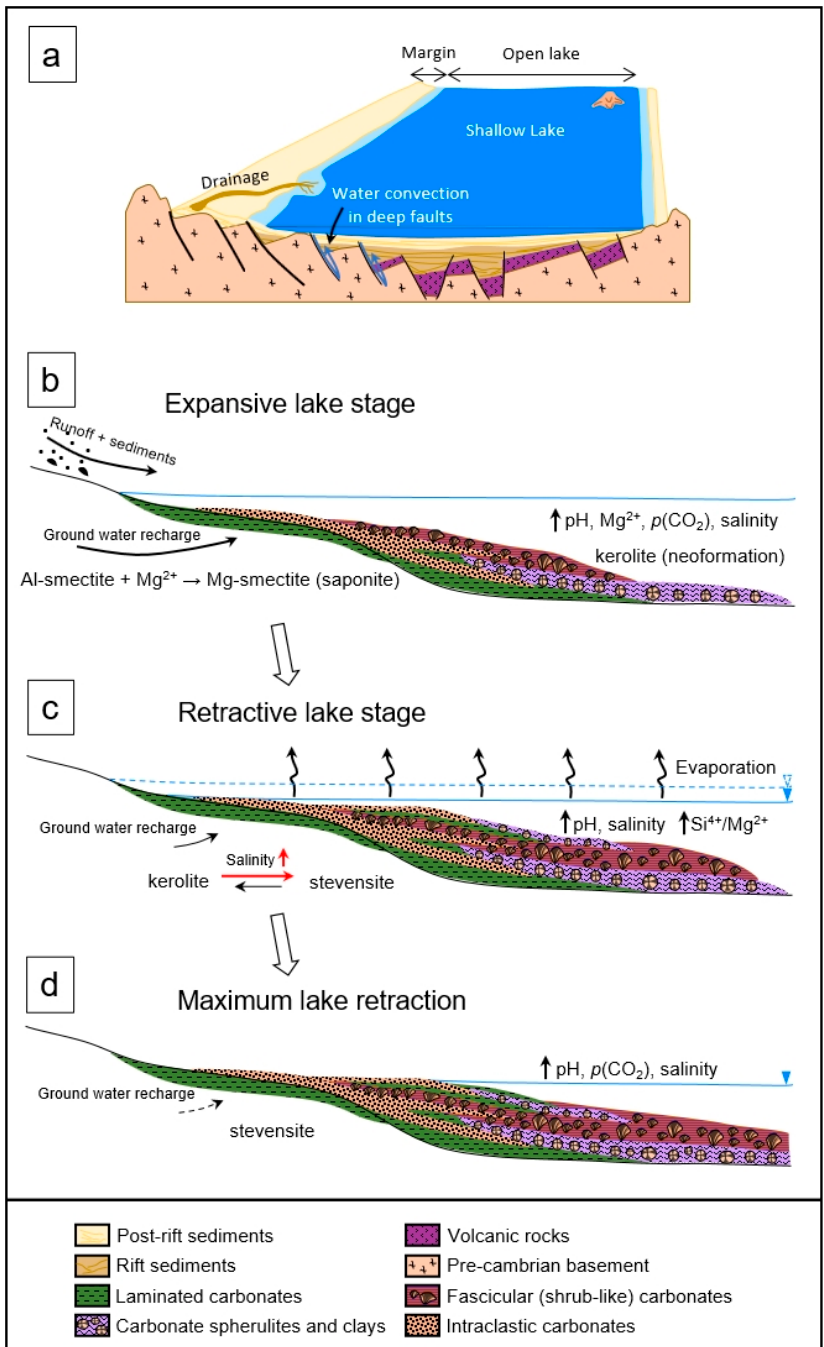
Figure 9. Scheme showing the conceptual depositional model for the post-rift stage, including main Mg-clay minerals authigenic pathways. ( a ) shows a simplified conceptual model illustrating the geology and hydrology of the Barra Velha Fm as a large and shallow endorheic lake (modified from Pietzsch [21]). ( b ) illustrate the expansive lake stage with runoff water and sediment discharge plus ground water contributing to lake water dilution favoring the neoformation of saponite by transformation of Al-smectite in a high Mg 2+ environment. ( c ) shows the retractive lake stage with a relative low salinity favoring the neoformation of kerolite. Variations in the salinity can favor neoformation of stevensite or generate kerolite-stevensite mixed layers. ( d ) represents the maximum lake retraction with high pH and salinity favoring stevensite neoformation (Modi- fied from Netto [2]).